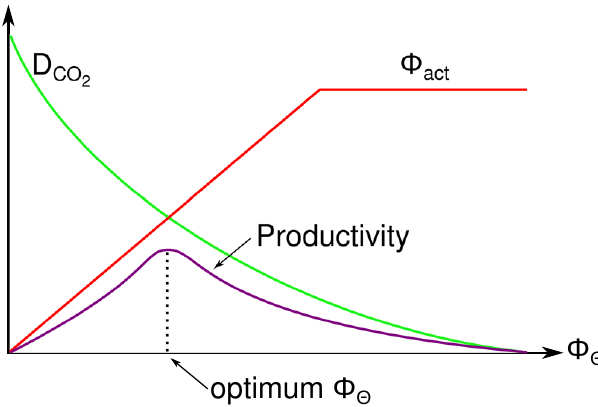
Fig. B12. Effect of water saturation 8 2 on CO 2 diffusivity D CO metabolic activity 8 act and on the associated productivity. The pro- ductivity has a maximum at an optimum 8 2